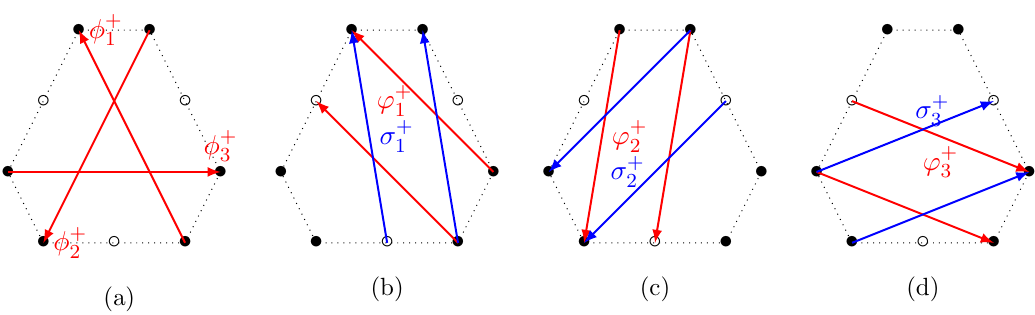
Figure 19. The rank 1 and 2 regular zero modes for the C [(2 ; 1)] brane, exemplifying the ( N; 1) case. The maximal Higgs (cid:30) + of (a) connect extremal weight states, while the next-to-maximal i Higgs ’ + , (cid:27) + of (b){(d) also relate extremal and non-extremal weight states. Only the latter are i i (approximately)